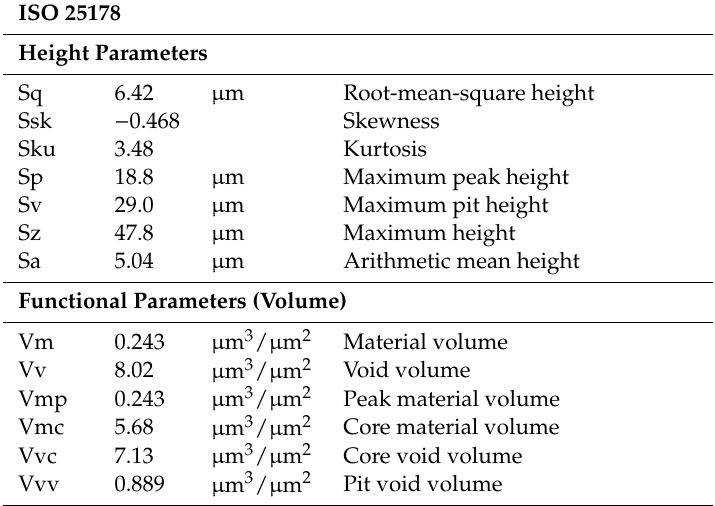
Figure A1. Original cable 5 topography (left) and it is corresponding grey level image (right). Table A1. List of the 34 roughness parameters and their numerical values corresponding to the map of cable 5 (Figure A1).